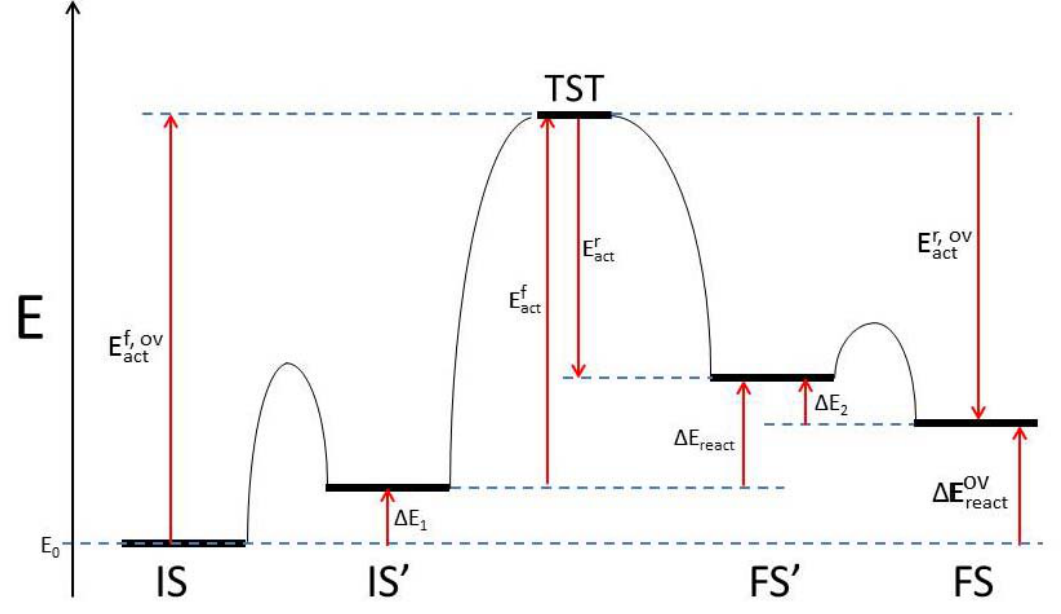
Figure 1. Schematic enthalpy diagram for a multi-step chemical reaction, as per the nomenclature of Table